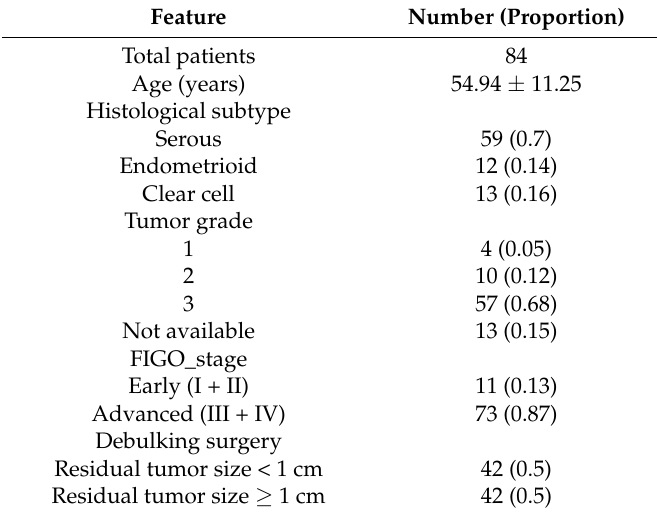
Table 1. Clinical characteristics of the epithelial ovarian cancer patients at